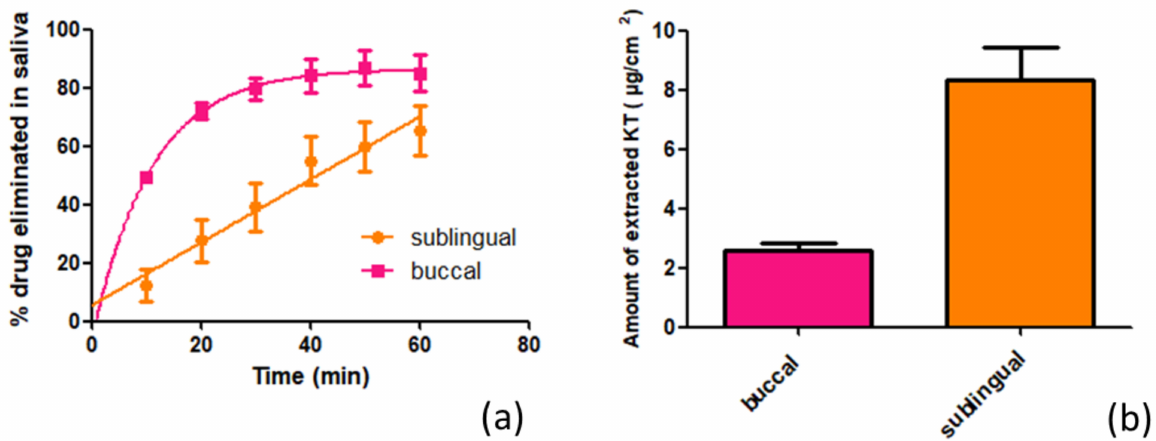
Figure 5. In vitro study of influence of saliva on drug elimination: ( a ) percentage of KT eliminated by the action of artificial saliva at a flow rate of 0.24 mL/min in buccal (pink curve) and sublingual (orange curve) mucosa as a function of time; ( b ) Amounts of KT extracted from the mucosa (buccal—pink; sublingual—orange) after the in vitro study. Results expressed as mean and SD (n =